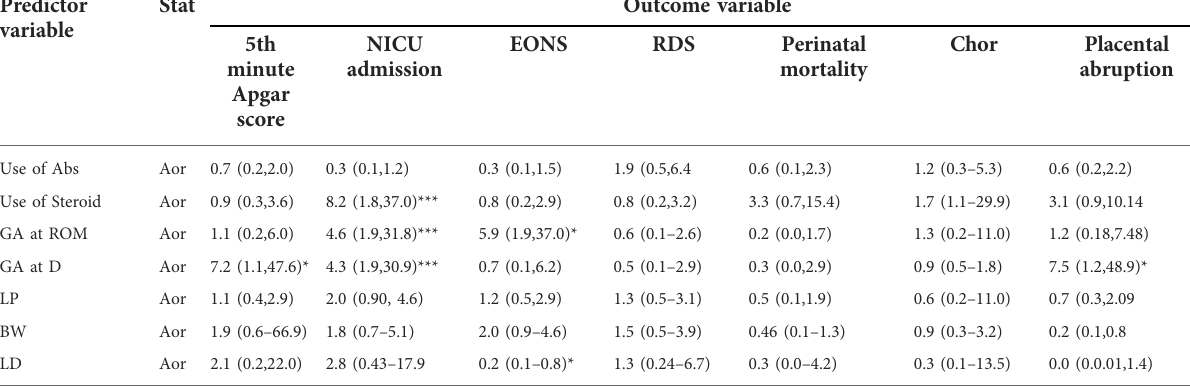
TABLE 9 Factors determining the major outcomes of the study among pregnant women with preterm premature rupture of membrane. Predictor